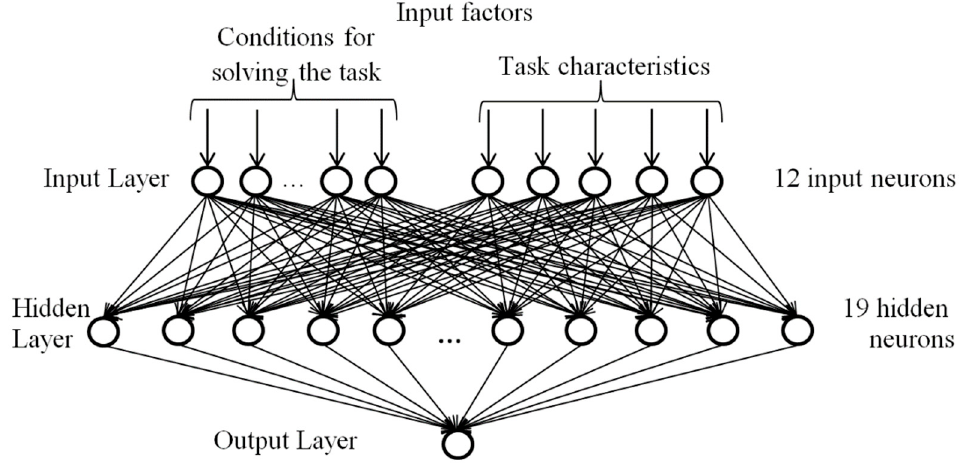
Figure 1. MLP structure.